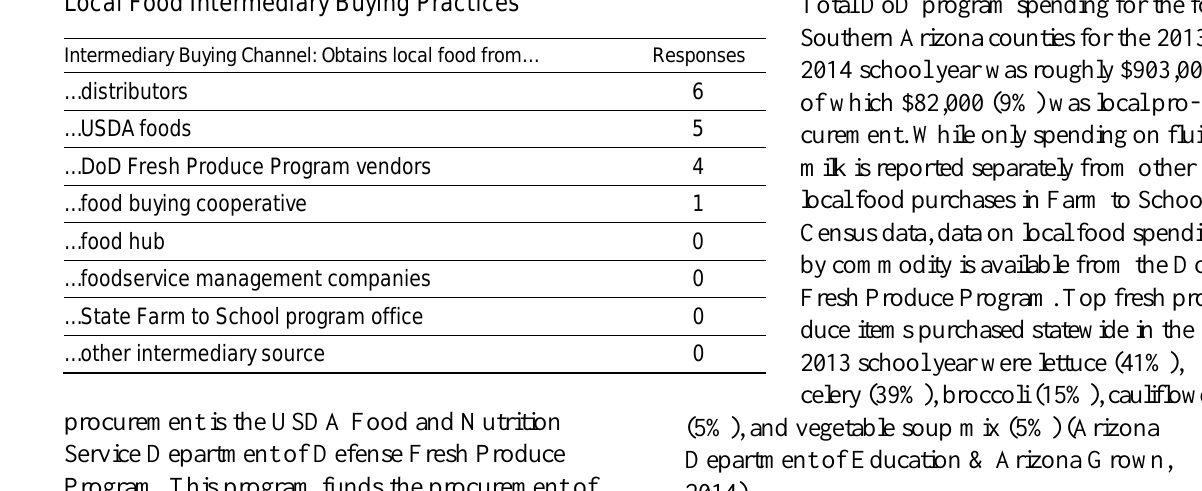
Table 5. Southern Arizona School Food Authorities’ (SFAs’) Local Food Intermediary Buying Practices